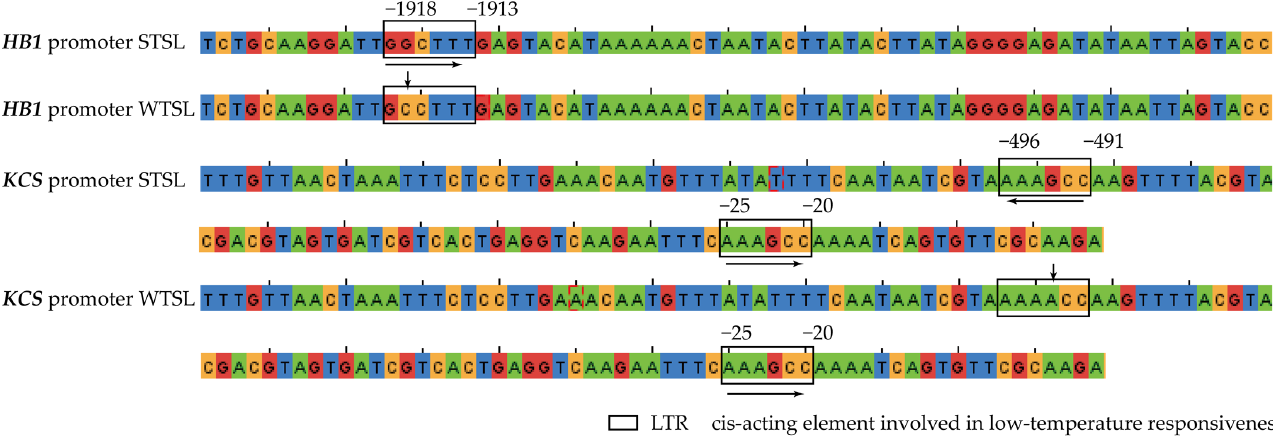
Figure 7. Prediction of cis-acting elements in HB1 and KCS promoter.